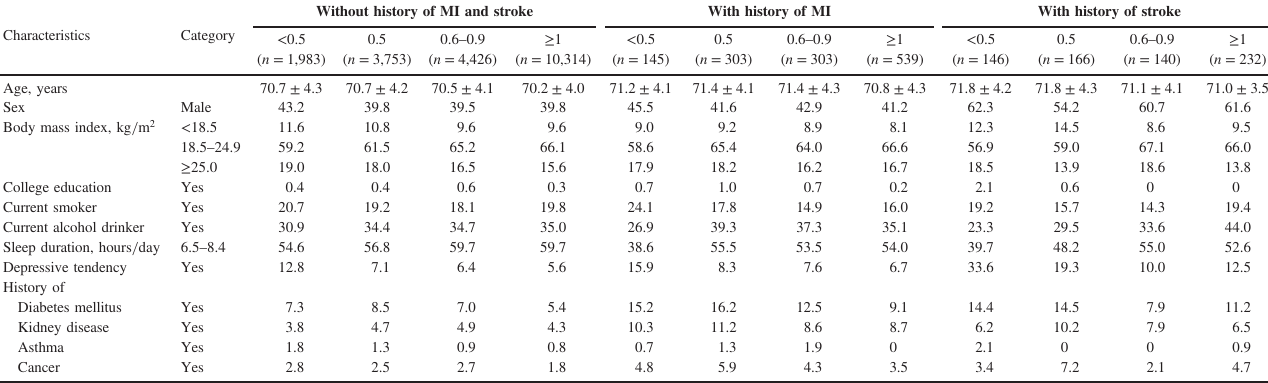
Table 1. Baseline characteristics of participants with / without history of MI or stroke according to daily walking time (hours / day)